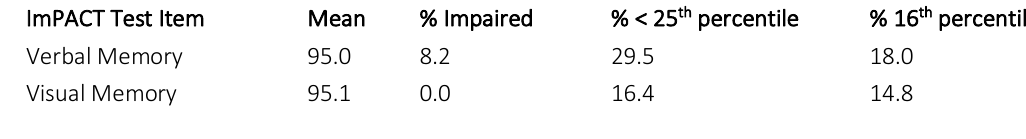
(Table created by authors with data from